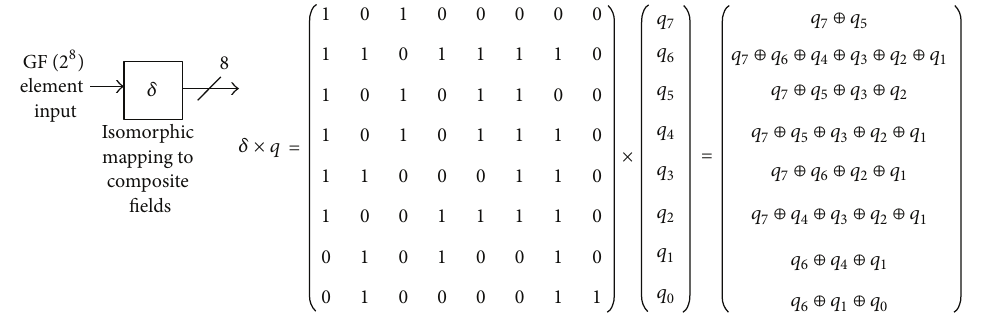
Figure 5: Illustration of isomorphic mapping.